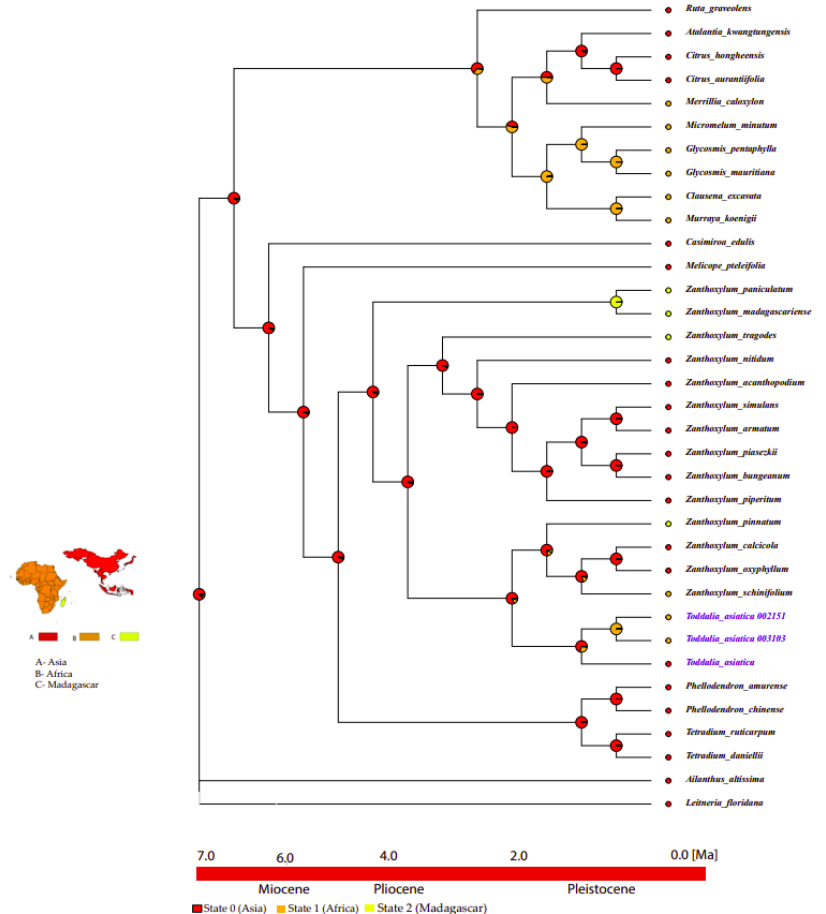
Figure 11. Ancestral area reconstructions of Toddalia species and closely related species based on the MBASR using R-software. The four biogeographical areas were defined based on the distribution of extant T. asiatica species. Area abbreviations: A, Asia; B, Africa; C, Madagascar. The base map was downloaded from Worldclim (https://www.worldclim.org, accessed on 26 September 2021).